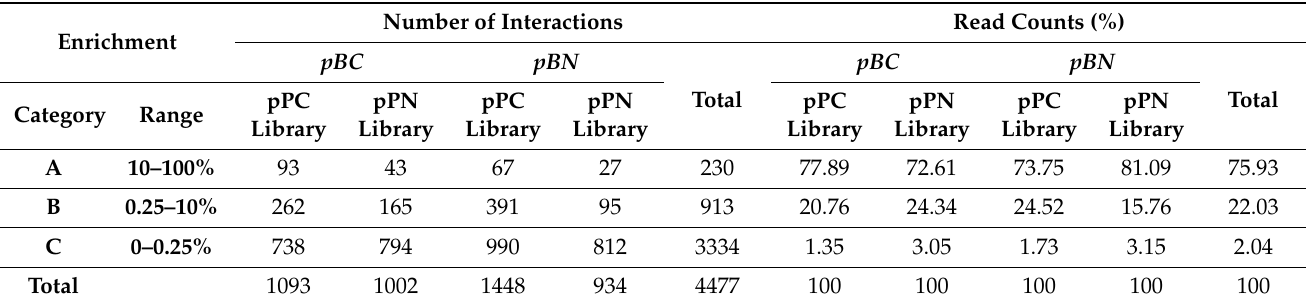
Table 1. Frequency of interactions for each enrichment category. The table shows the total number of interactions and the proportion of sequencing reads (counts) that fell into each enrichment category (A for prey proteins detected as 10–100% of the sample counts, B for 0.25–10%, and C for